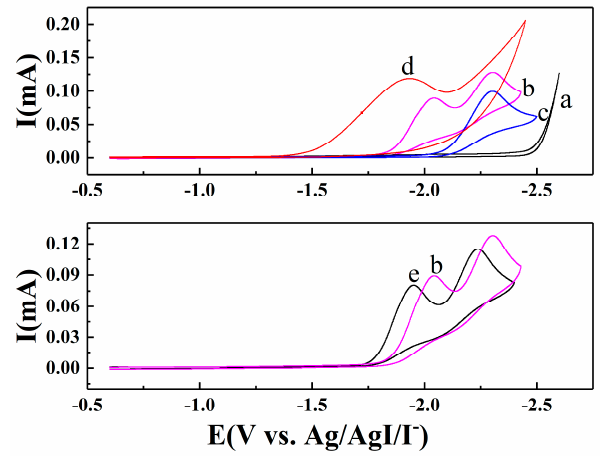
Figure 1. Cyclic voltammograms obtained with the scan rate of 0.1 V/s in DMF + 0.1 M TEABF 4 ‐ : ( a ) blank cyclic voltammetry on GC electrode; ( b ) as (a) +5 mM 1,4 ‐ dichlorobenzene; ( c ) as (a) +5 mM chlorobenzene; ( d ) as ( b ) in the presence of CO 2 ; ( e ) cyclic voltammetry of 5 mM 1,4 ‐ dichlorobenzene on Ag electrode.